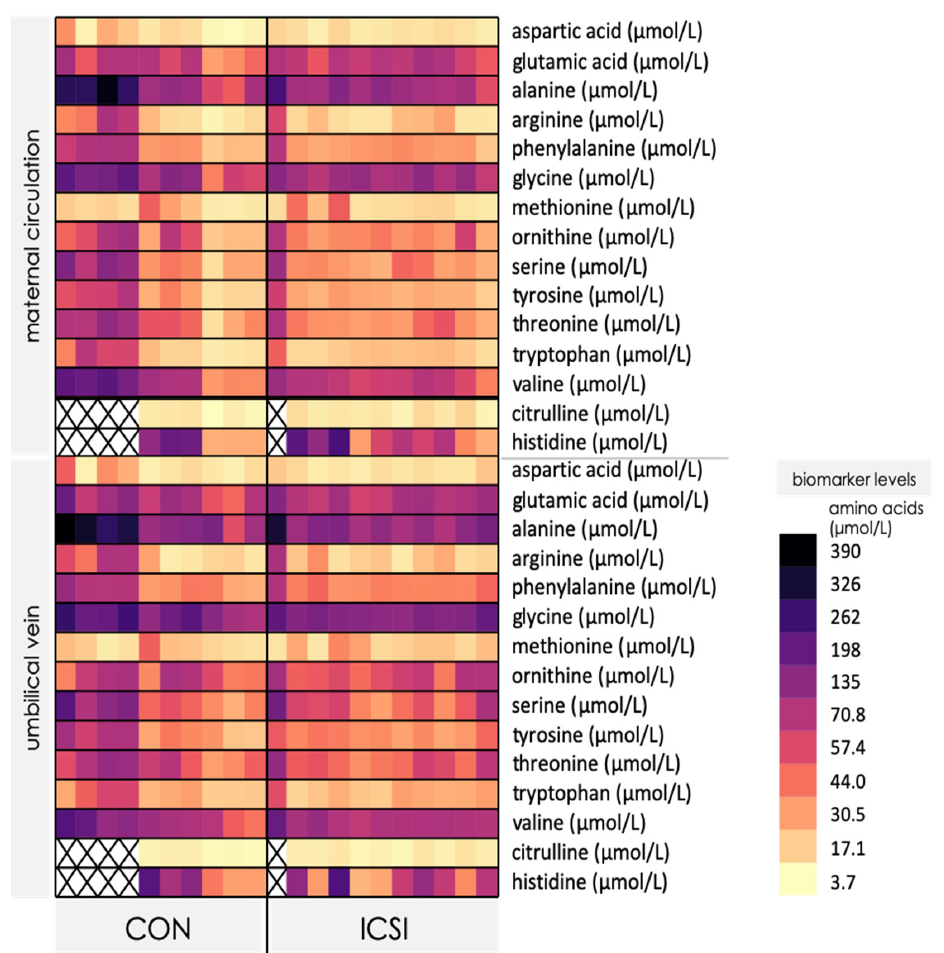
Figure 2. Heatmap of free amino acid levels in maternal circulation and umbilical vein in control, naturally conceived (CON; n = 10) and ICSI ( n = 11) term pregnancies. Each column represents the nutrient profile of an individual pregnancy (maternal and umbilical vein). Darker colors indicate higher biomarker concentrations whereas lighter colors indicate lower biomarker concentrations. X = no value measured. Refer to Supplementary Tables S1 and S2 for values.